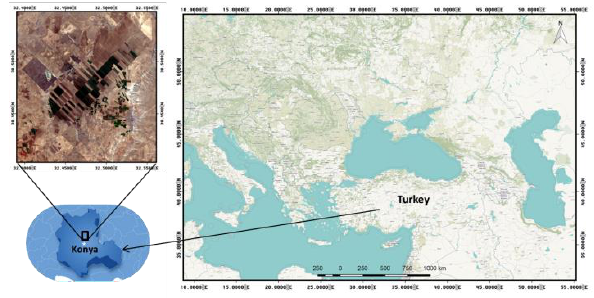
Figure 1. The location map of the study area